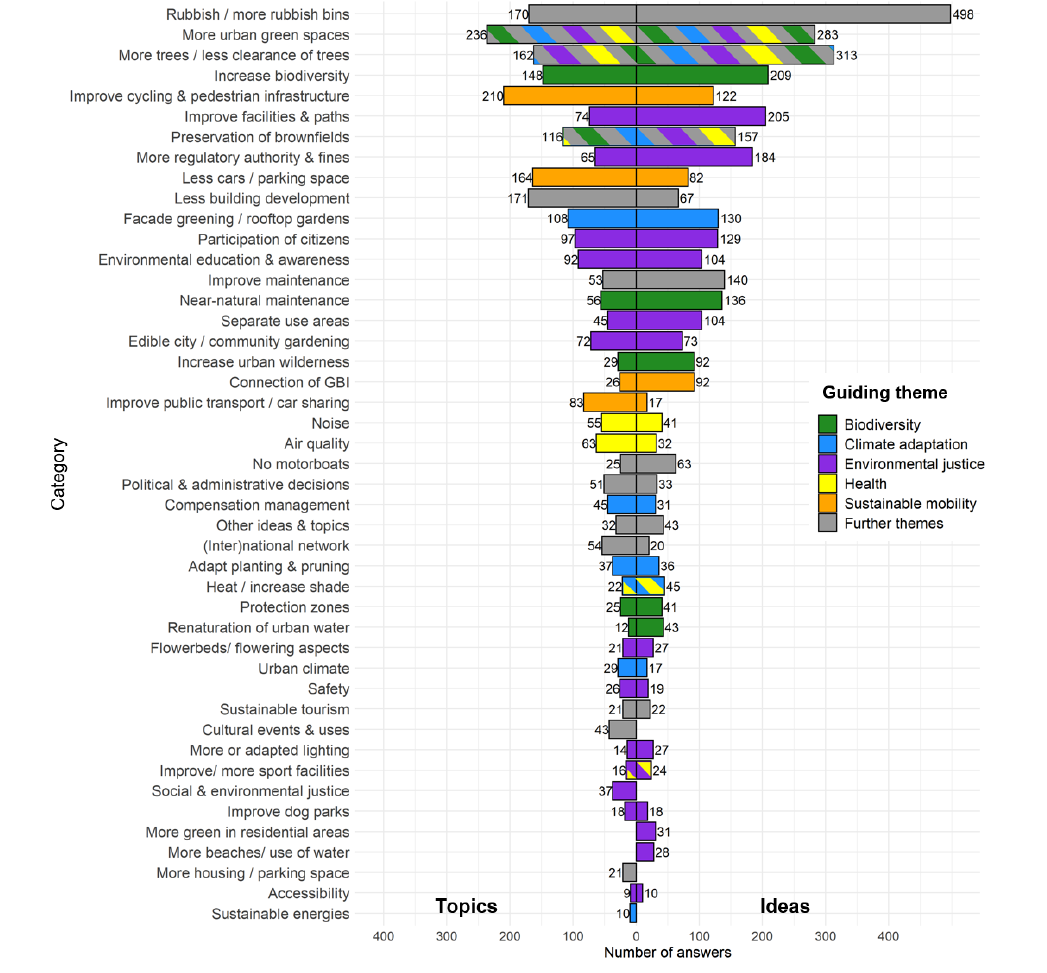
Fig. 1 . Ideas (n = 3808 from 1851 respondents) and further topics (n = 2917 from 1228 respondents) of citizens to improve GBI of Leipzig, aggregated into categories. In an open question, respondents could name ideas to improve Leipzig’s GBI and further topics that are important to them and should be included in the Master Plan Green. The colors represent the allocation to one or several (hatched) of the five guiding themes that are leading the development of the Master Plan Green in Leipzig (Biodiversity, Climate adaptation, Environmental justice, Health, Sustainable mobility). Aspects that were not covered by a guiding theme are colored in gray (Further